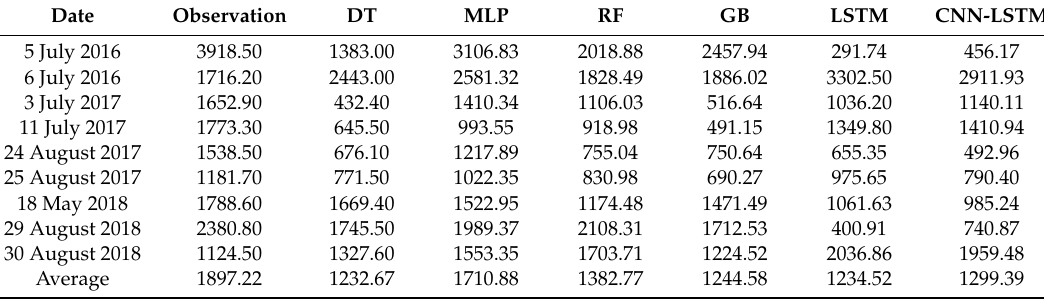
Table 5. Prediction values of machine learning models for observed cases of over 1000 m 3 / s of Soyang River Dam